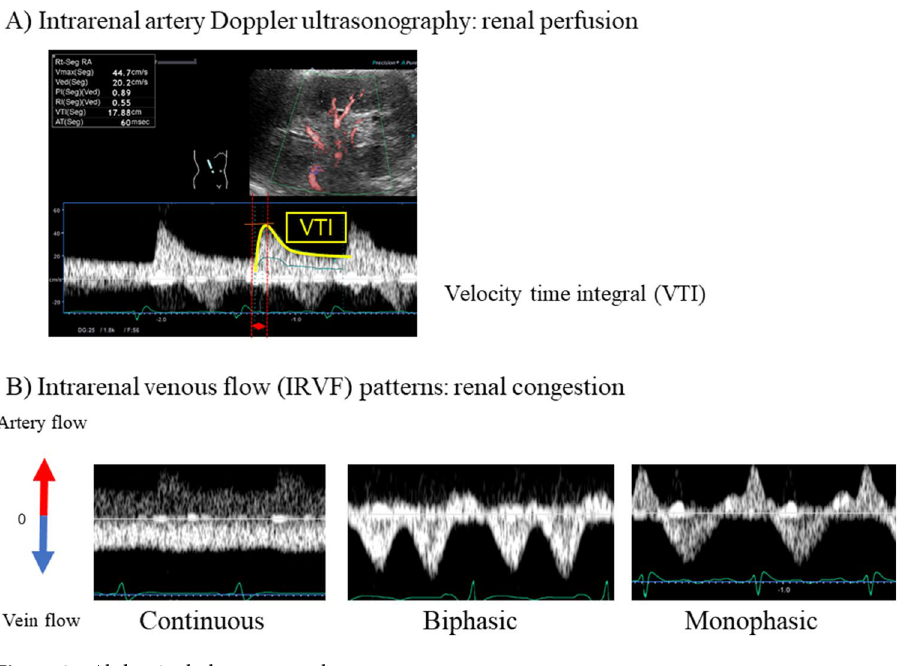
Figure 3. Abdominal